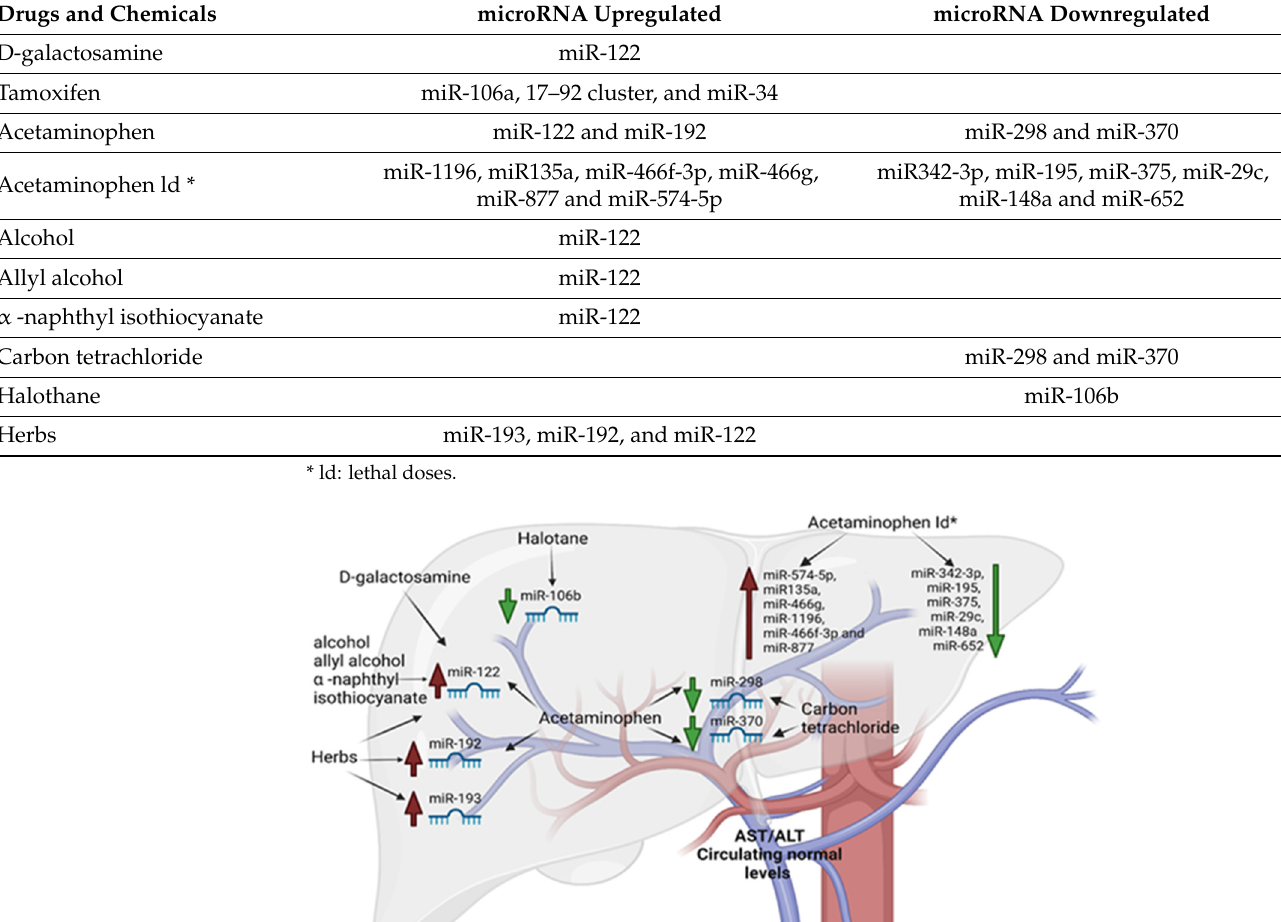
Table 2. Circulating miRNAs as early DILI biomarkers.